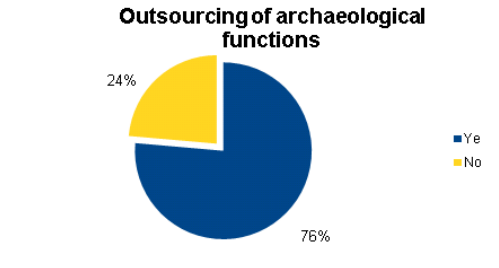
Figure 24 - Shortage of skills in archaeological functions